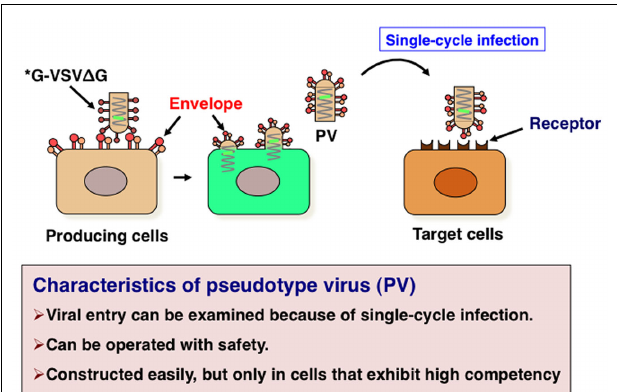
FIGURE 1 | Schematic representation of the production of pseudotype VSV. Producer cells were transfected with an expression plasmid encoding foreign envelope genes and then infected with aVSV G-complemented pseudotype virus (*G-VSV Δ G).The pseudotype virus released from the producer cells infected target cells but was not able to produce infectious progeny viruses.